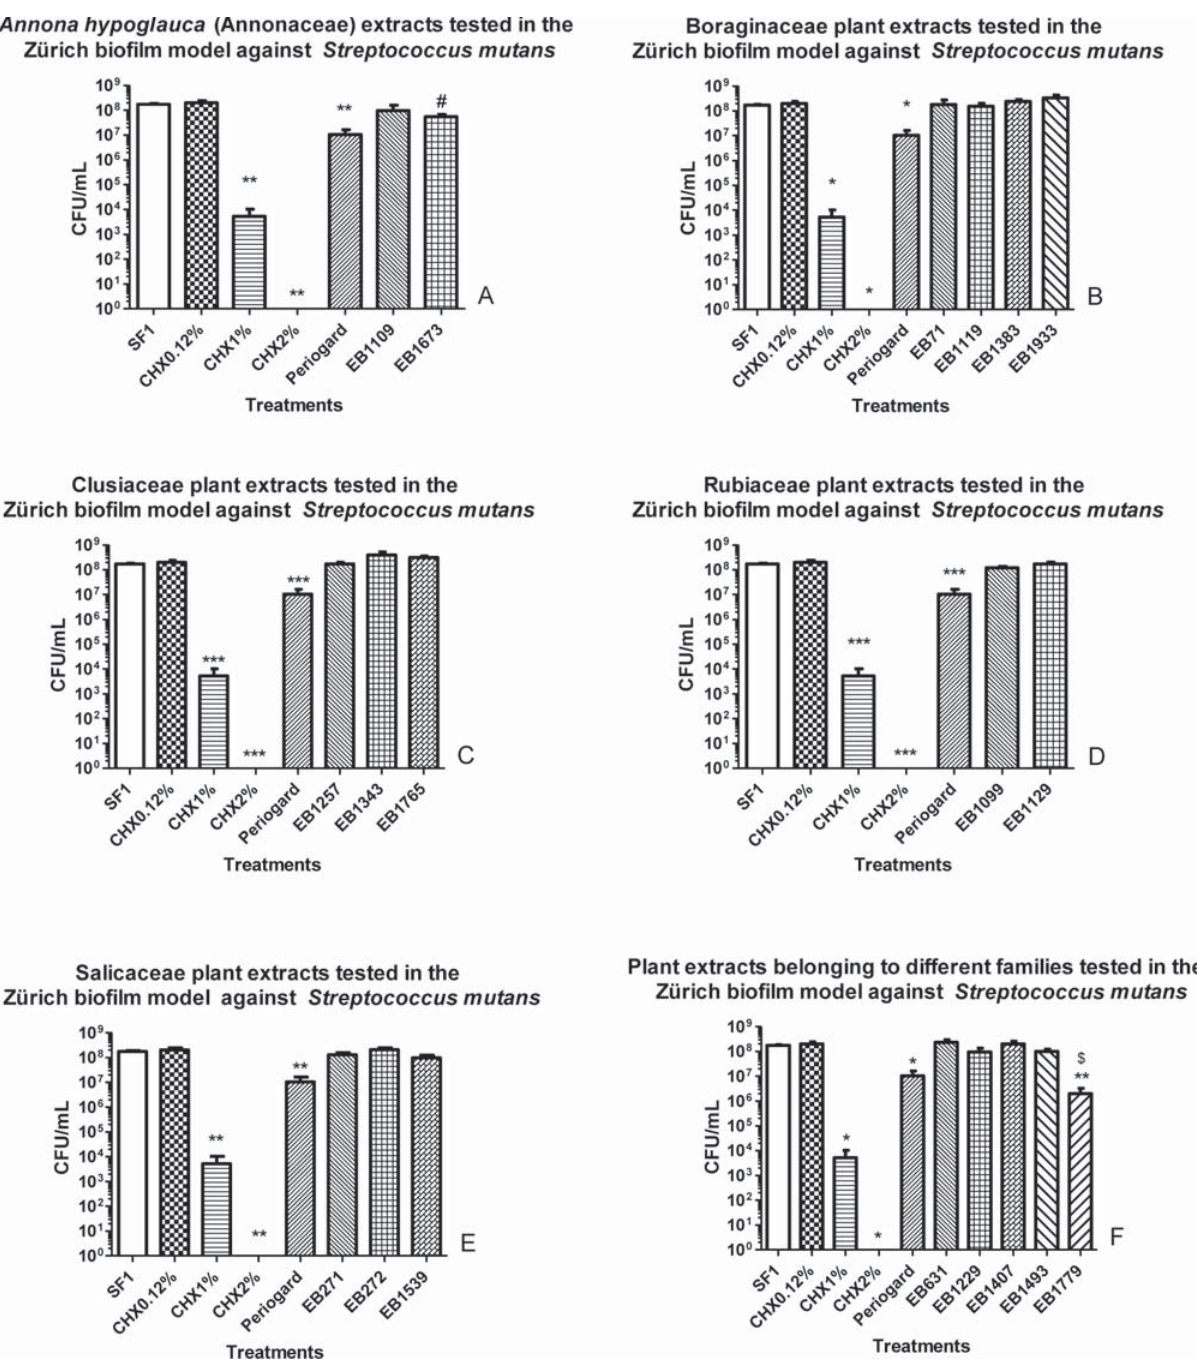
Figure 2- (cid:4)(cid:27)(cid:11)(cid:19)(cid:9)(cid:29)(cid:10)(cid:19)(cid:4)(cid:13)&(cid:10)(cid:7)(cid:16)(cid:17)(cid:11)(cid:8)(cid:4)(cid:25)(cid:6)(cid:13)(cid:15)(cid:4)(cid:10)(cid:28)(cid:11)(cid:4)&(cid:7)(cid:23)(cid:10)(cid:11)(cid:6)(cid:16)(cid:7)(cid:29)(cid:4)(cid:23)(cid:13)(cid:9)(cid:17)(cid:10)(cid:4)(cid:10)(cid:28)(cid:7)(cid:10)(cid:4)(cid:6)(cid:11)(cid:15)(cid:7)(cid:16)(cid:17)(cid:11)(cid:8)(cid:4)(cid:25)(cid:6)(cid:13)(cid:15)(cid:4)&(cid:16)(cid:13)(cid:26)(cid:29)(cid:15)(cid:4)(cid:10)(cid:6)(cid:11)(cid:7)(cid:10)(cid:15)(cid:11)(cid:17)(cid:10)(cid:4)’(cid:16)(cid:10)(cid:28)(cid:4)*(cid:15)(cid:7)$(cid:13)(cid:17)(cid:4)+(cid:29)(cid:7)(cid:17)(cid:10)(cid:4)(cid:11)%(cid:10)(cid:6)(cid:7)(cid:23)(cid:10)(cid:19);(cid:4)(cid:24)(cid:17)(cid:11)(cid:3)